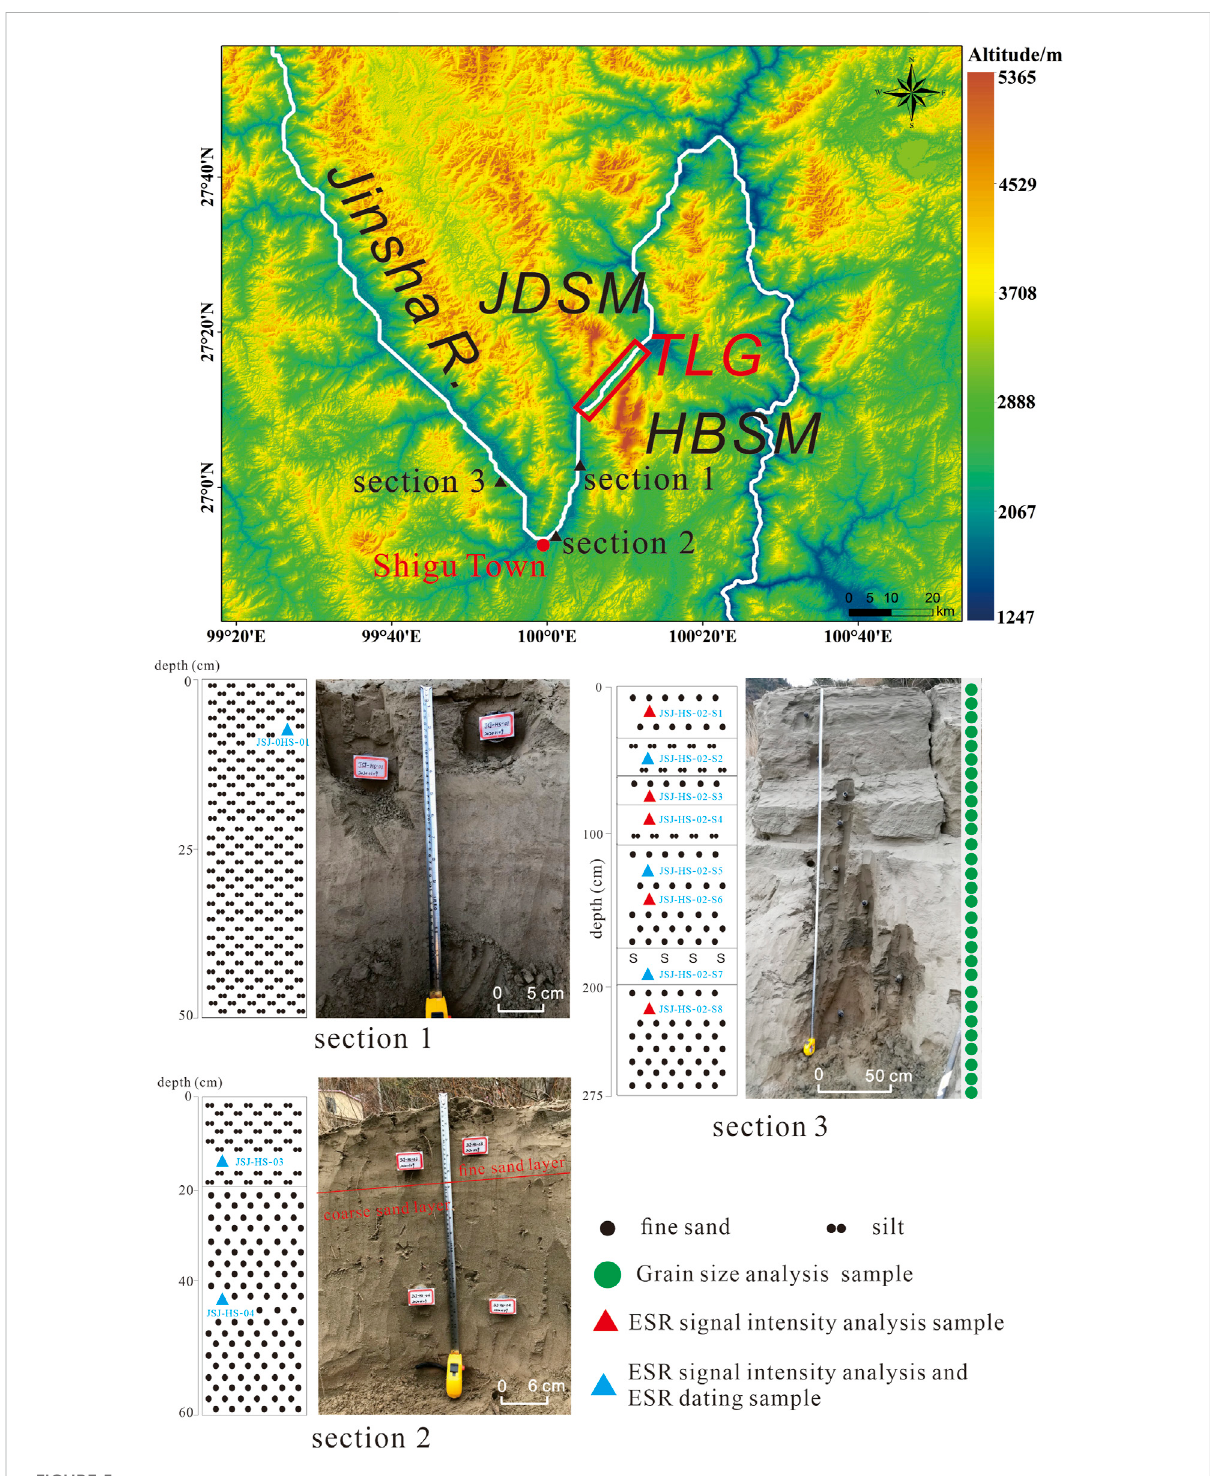
FIGURE 5 Locations and fi eld photos of sampling sections, and their lithological sections. JDSM: Jade Dragon Snow Mountain; HBSM: Haba Snow Mountain; TLG: Tiger Leaping